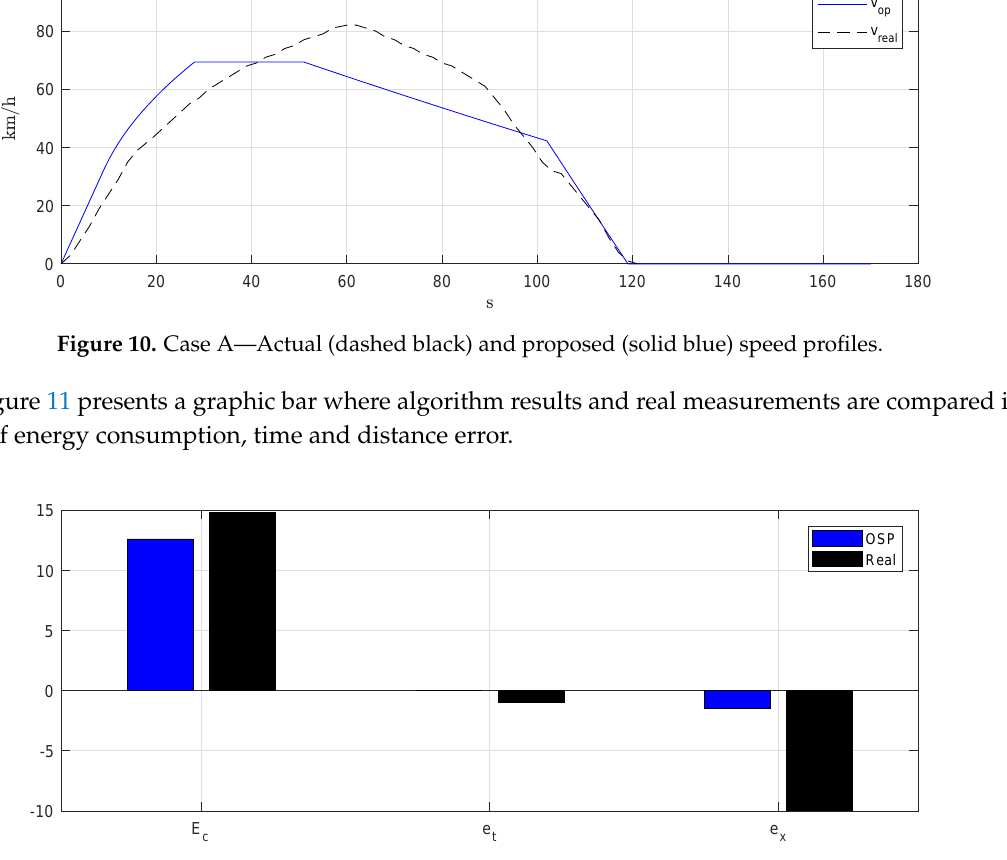
Figure 11. Case A—Real (black) and simulated (blue) energies (kWh), traveling times (s) and distance errors